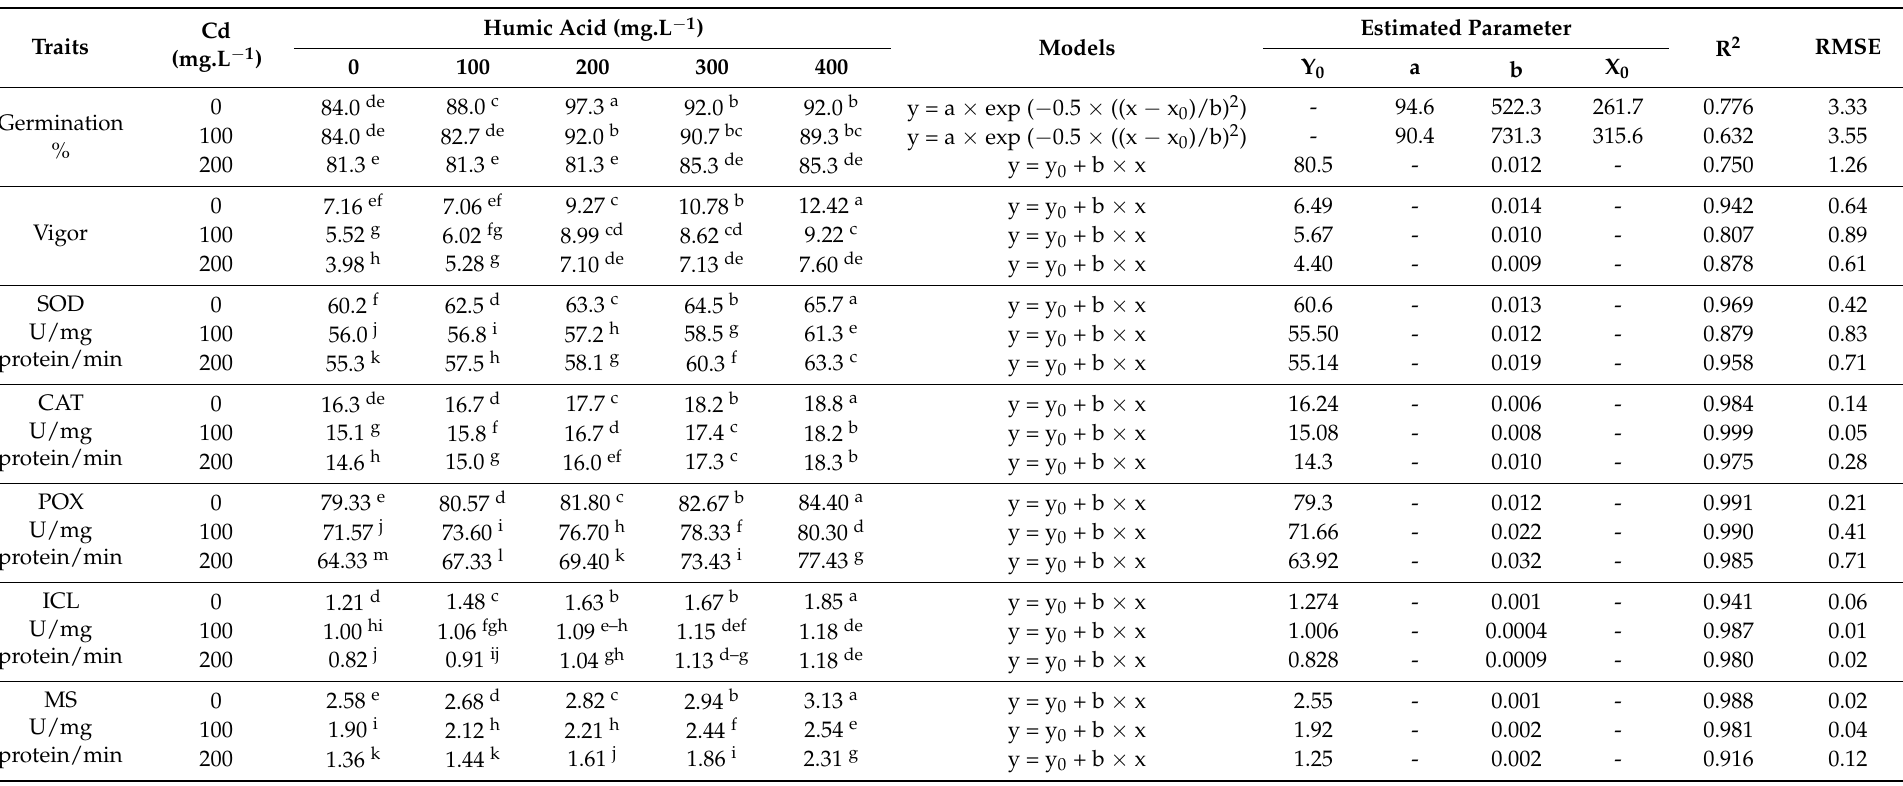
Table 1. Means and estimated parameters of germination and vigor and some antioxidant enzyme activities of pumpkin seeds ( Cucurbita pepo L.) influenced by humic acid under cadmium (Cd)